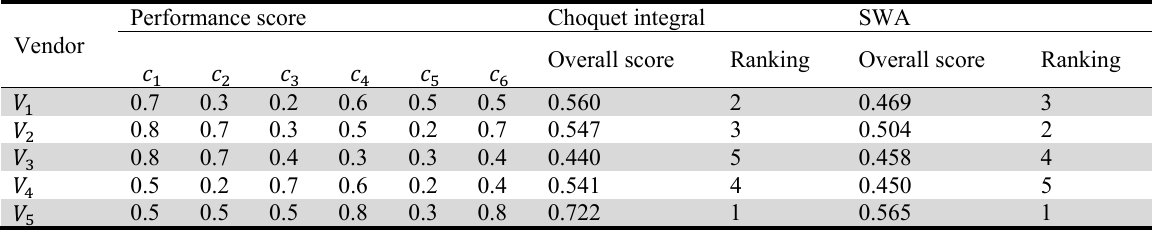
Results of Choquet integral versus SWA